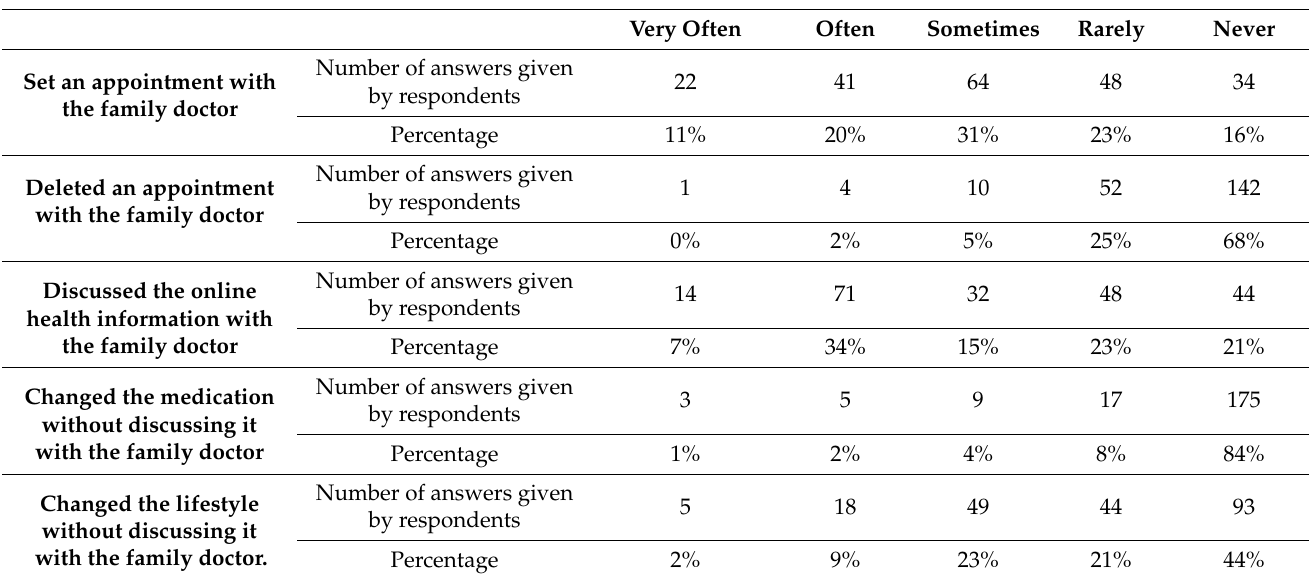
Table 12. Behavior after searching for online health